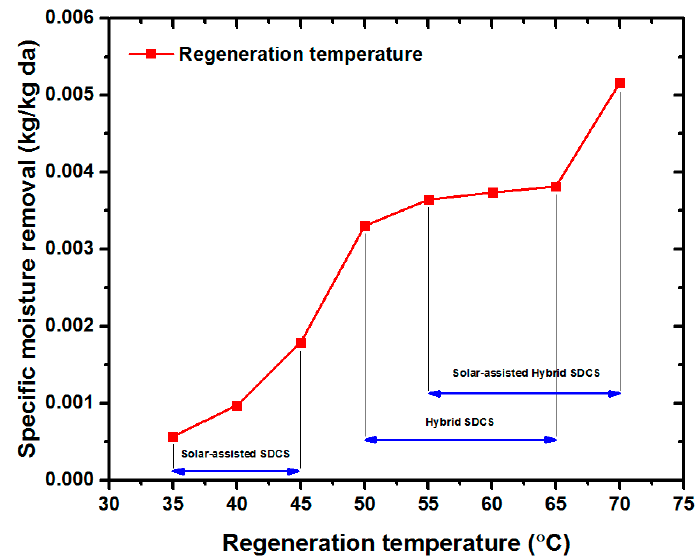
Figure 9. E ff ect of regeneration temperature on SMR Figure 9. Effect of regeneration temperature on SMR .